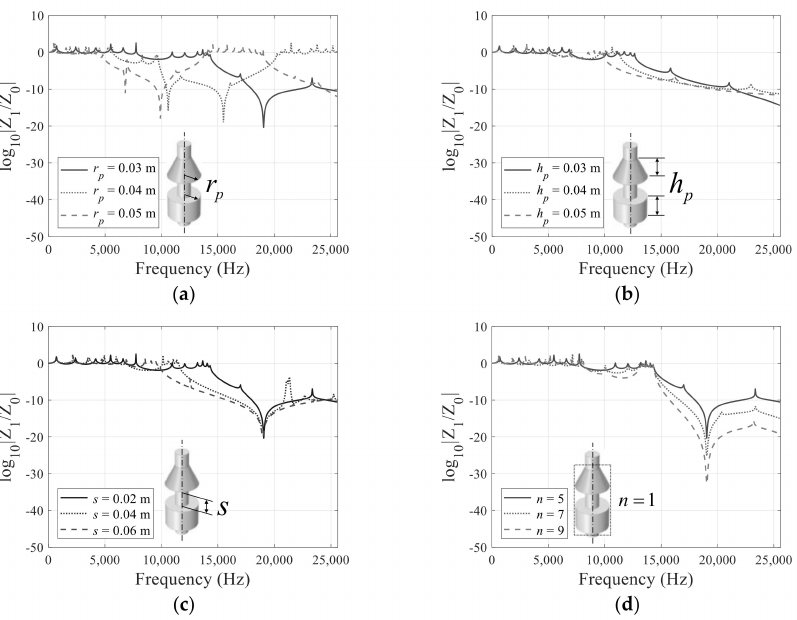
Figure 12. Frequency response analysis results for each parameter of straight bar with repeated cylinder and conical of the metamaterials for the longitudinal wave: ( a ) h p = 0.02 m, n = 5, d = 0.02 m ( b ) r p = 0.03 m, n = 5, d = 0.02 m ( c ) r p = 0.03 m, h p = 0.02 m n = 5 ( d ) r p = 0.03 m, h p = 0.02 m d = 0.02